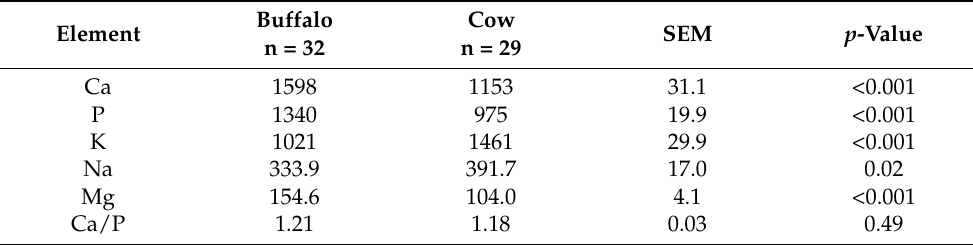
Table 1. Essential macro mineral concentrations (mg/L) and Ca:P ratio in buffalo and cow milk. Element